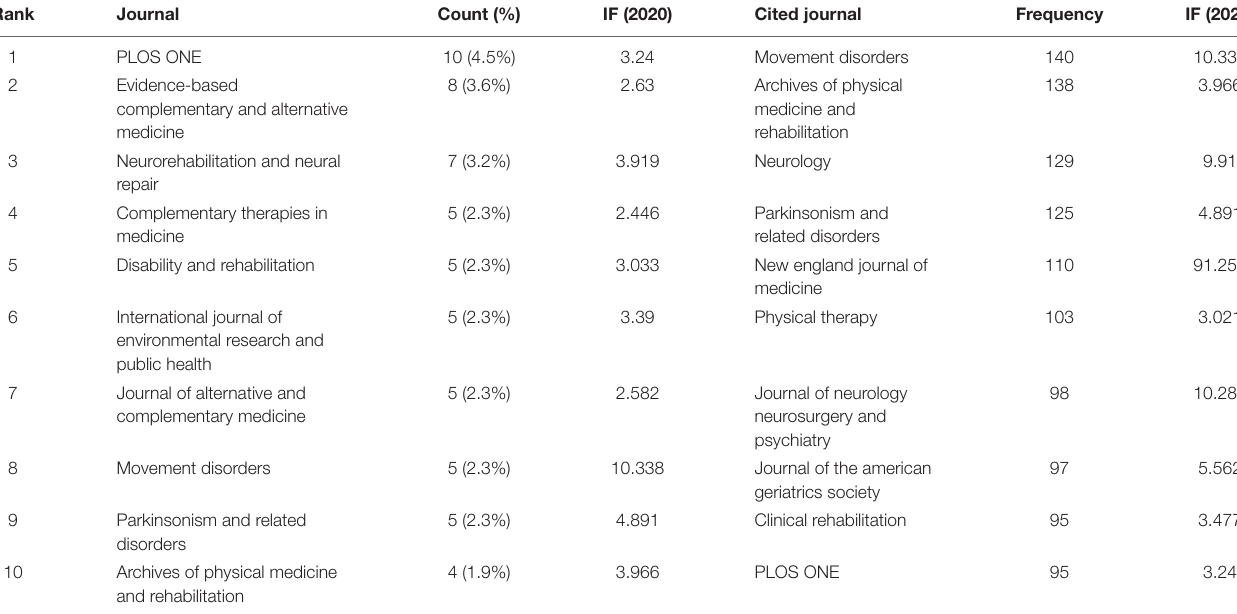
TABLE 5 | The top 10 prolific journals and cited journals.